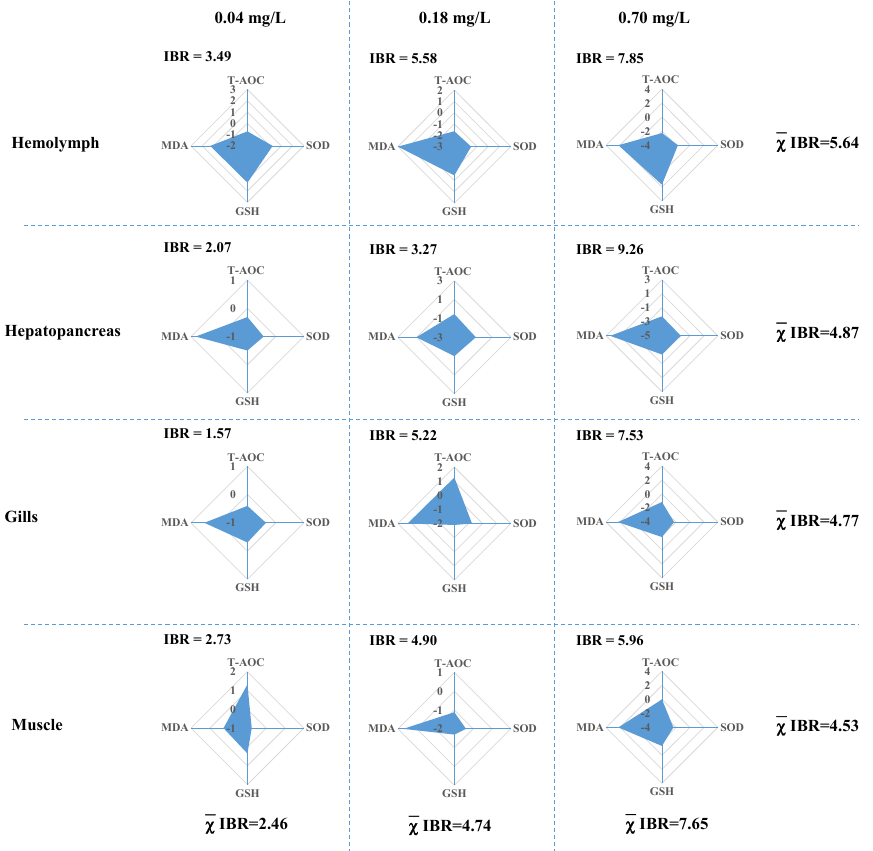
Figure 2. IBR index of the oxidative stress response to different concentrations of copper in the hemolymph, hepatopancreas, gills, and muscle. Biomarker values are represented in relation to the control group. The areas above zero reflect an increase in the biomarker, and the areas below zero reflect a decrease in the biomarker.